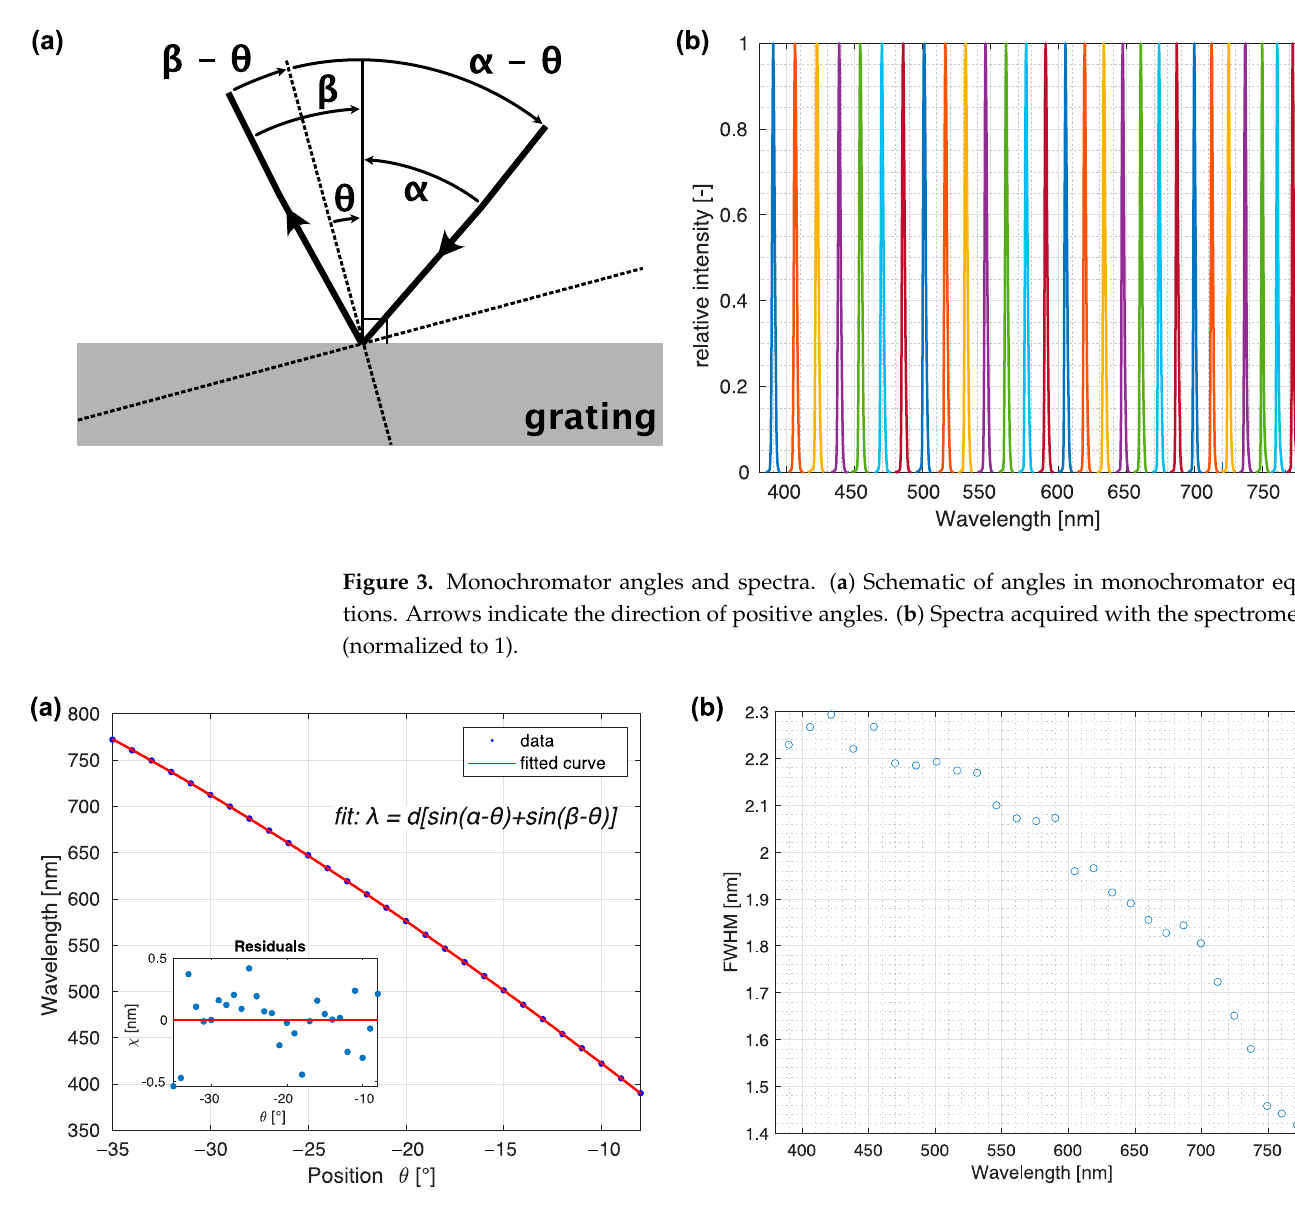
Figure 4. Monochromator calibration. ( a ) The relation between monochromator positions obtained from the rotation stage encoder and measured central wavelengths (blue dots) is calculated by fitting the grating formula (Equation (4), red line). ( b ) FWHM (full width at half maximum) as calculated from spectral measurements.